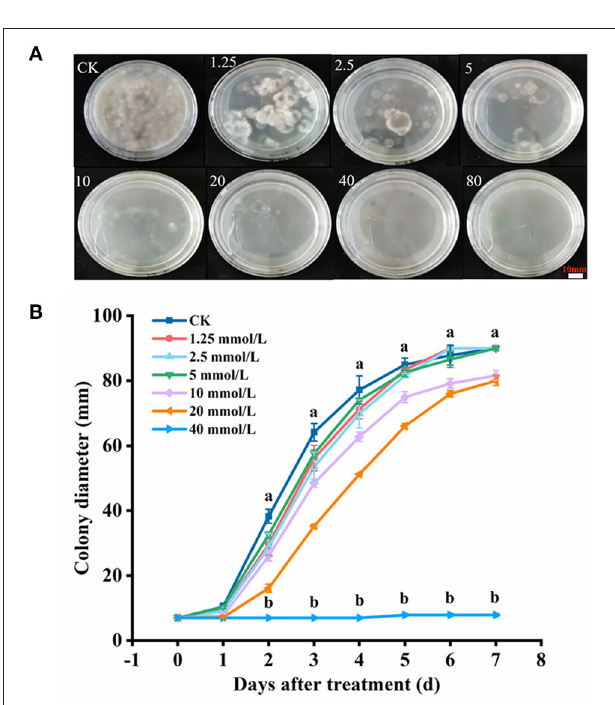
FIGURE 2 | Mycelial growth (A) and colony diameter (B) of B . dothidea with H 2 S treatment. The NaHS solution (H 2 S donor) was added to make the final concentration of 0, 1.25, 2.5, 5, 10, 20, 40, and 80 mmol L − 1 , respectively. Vertical bars represent the standard errors. Letters indicate significant differences ( P <